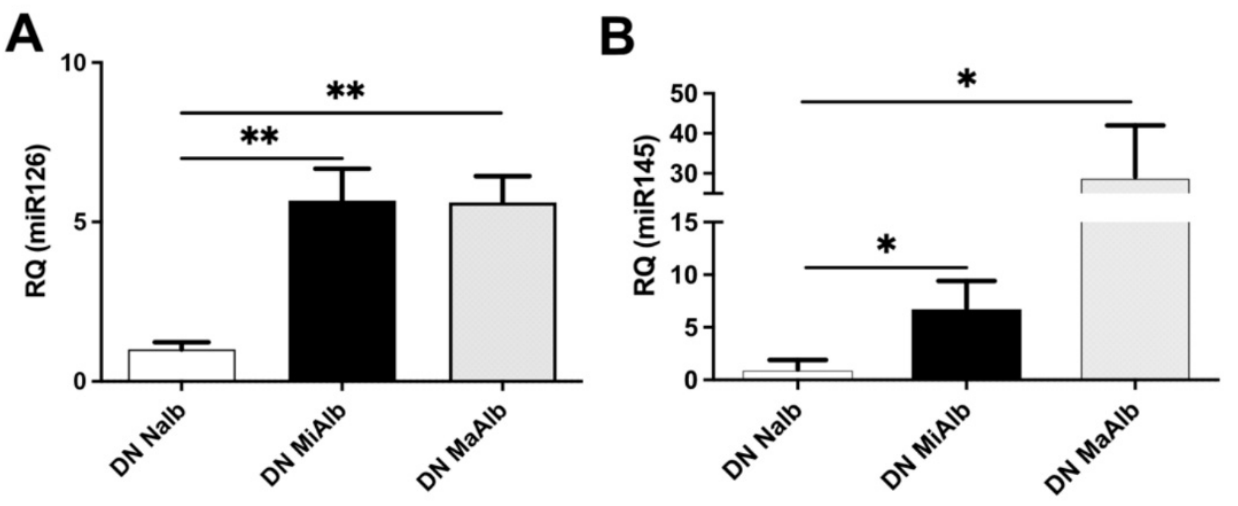
Figure 2. Relative quantification of miR126 ( A ) and miR145 ( B ) in the uEVs of patients divided in